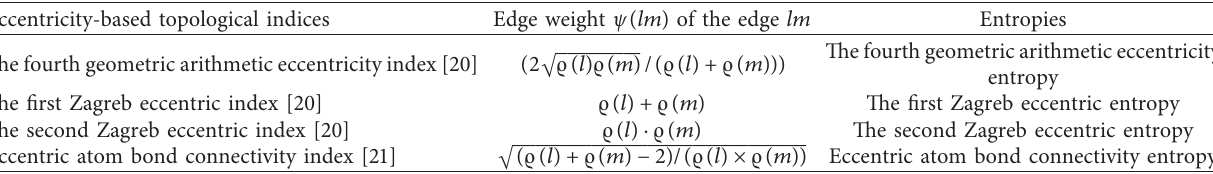
Table 1: Eccentricity-based topological indices along with their respective edge weight ψ ( lm ) of the edge lm .